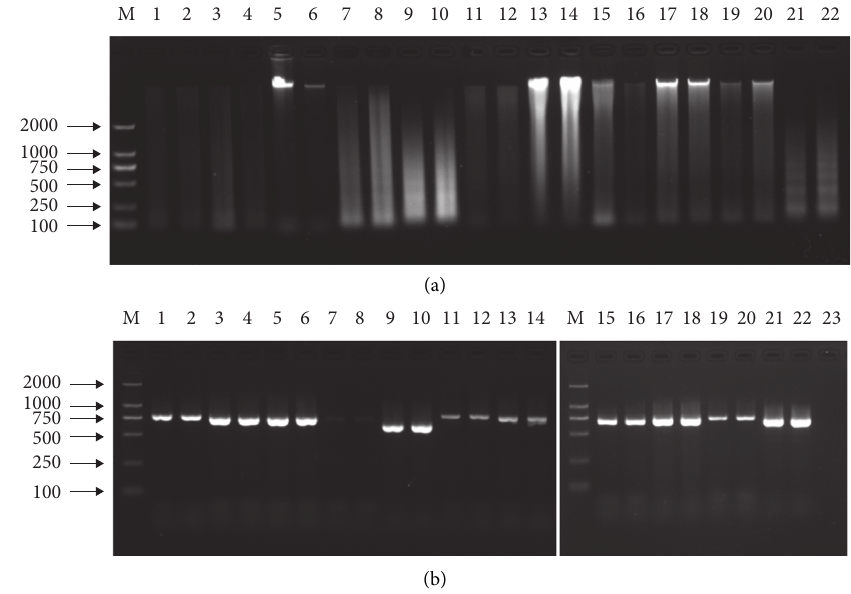
Figure 1: The DNA extraction results by the kit method. (a) The electrophoresis profile of genomic DNA extracted from the 11 tested species of fungi. (b) The electrophoresis profile of the PCR products amplified by ITS primers. M DNA marker DL 2000; lanes 1-2, Boletus magnificus W.F.Chiu; 3-4, Lentinus edodes ; 5-6, Boletus reticulatu s; 7-8, Agrocybe aegiri t; 9-10, Leccinum extremiorientale (L.Vass.) Singer; 11-12, Boletus griseus Frost; 13-14, Boletus sinicus W.F.Chiu; 15-16, Russula virescens ; 17-18, Collybia albuminosa ; 19-20, Lactarius volemus ; 21-22, Pleurotus eryngii Table 3: The purity and concentration of the DNA extracted by the kit method ( a ± SD, n � 3). Fungi